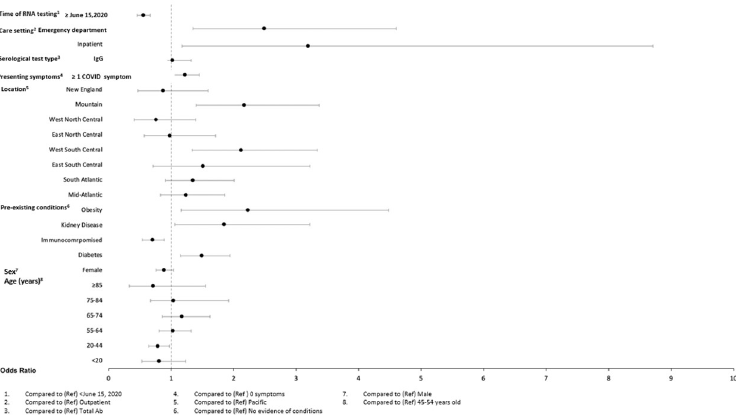
Fig 5. Odds of seropositivity dataset B.